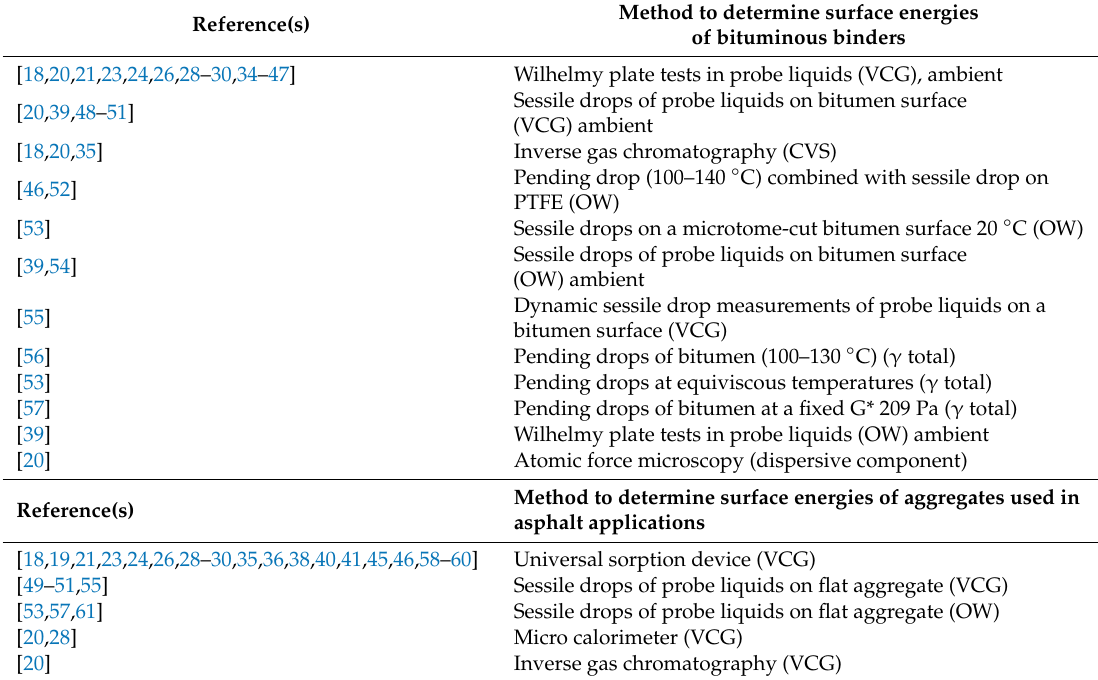
Table 1. Literature overview indicating the test methods used to determine surface energies of bitumen and